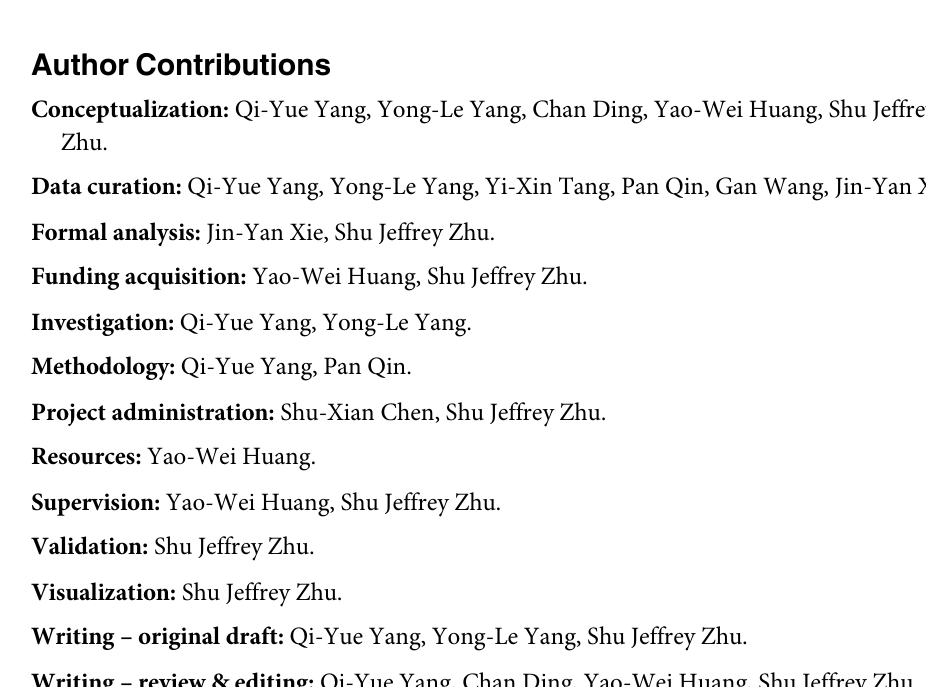
S3 Fig. Cellular viability under the treatment of different chemical additives. Cytotoxic effect of (A) TGR5 agonist INT-777 and FXR agonist INT-747, (B) TGR5 antagonist triamter- ene and FXR antagonist guggulsterone, (C) M β CD, (D) chlorpromazine (CME inhibitor), amiloride (macropinocytosis inhibitor), nystatin (CavME inhibitor) and dynasore (dynamin 2 inhibitor), in porcine intestinal enteroids (PIEs) at the indicated concentrations. (E) PIE monolayers were treated with either medium alone or 30 μ M chlorpromazine for 1 h, washed with PBS three times and incubated with 25 μ g/mL Alexa-594-labeled transferrin for 30 min at 37˚C (scale bar, 10 μ m). Images were collected on an LSM880 confocal laser-scanning micro- scope (Zeiss). (F) PIE monolayers were treated with either medium alone or 100 μ M amiloride for 1 h, washed with PBS three times and incubated with 1mg/mL FITC-labeled 70kDa dextran for 30 min at 37˚C (scale bar, 10 μ m). Images were collected on an LSM880 confocal laser- scanning microscope (Zeiss). Cytotoxic effect of (G) NH Cl and bafilomycin A1, (H) cathepsin 4 inhibitors E-64 and teicoplanin (I) LCA in porcine intestinal enteroids (PIEs) at the indicated concentrations. S1 Table. Primer sets used for quantitative reverse